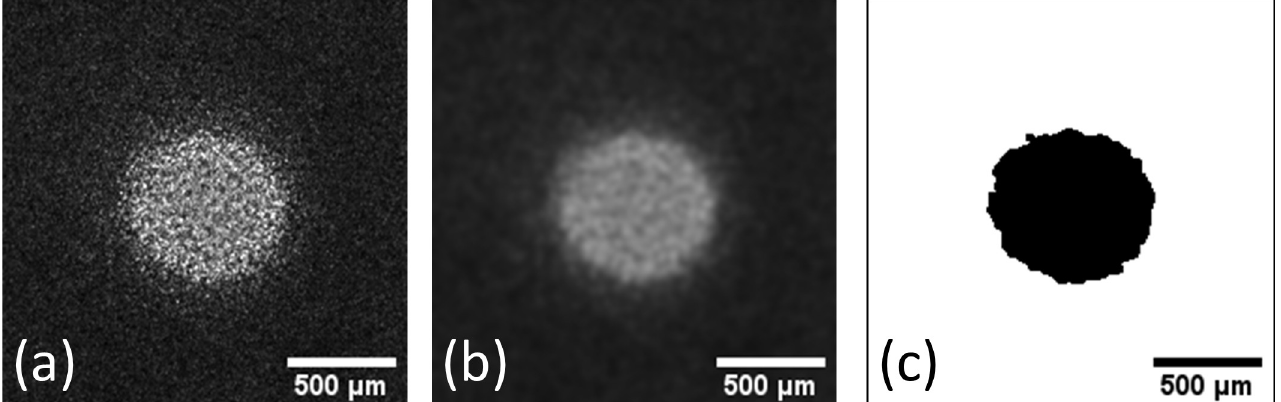
Fig 3. Image processing for plaque growth kinetics study. (a) Unprocessed phage plaque image (b) After a Gaussian blur filtering (c) Binarized final image.